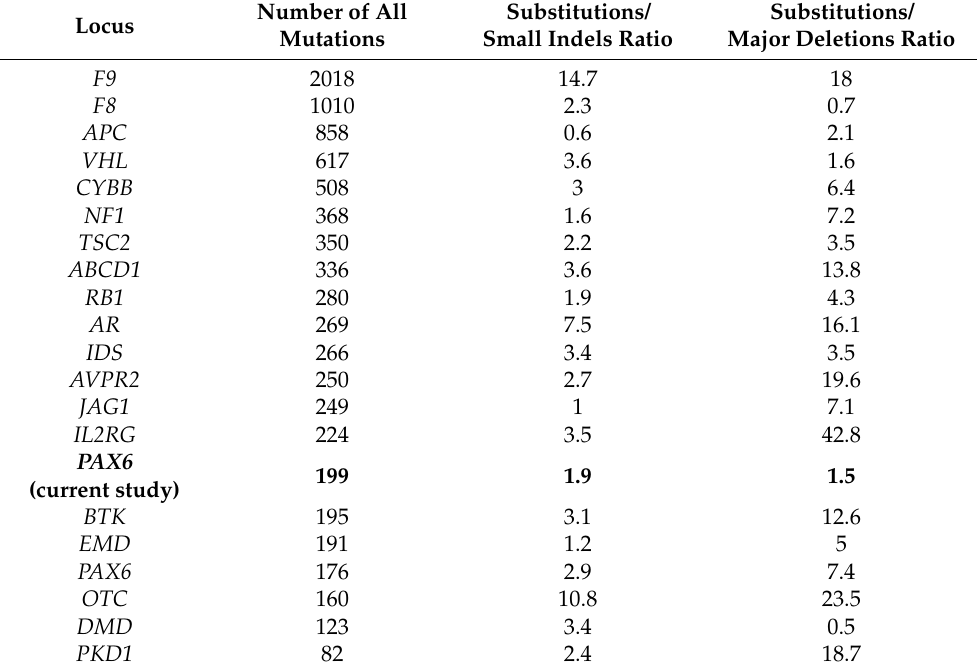
Table 2. The ratio of mutation events from Kondrashov’s review and the current study (highlighted in bold). Number of All Substitutions/ Locus Mutations